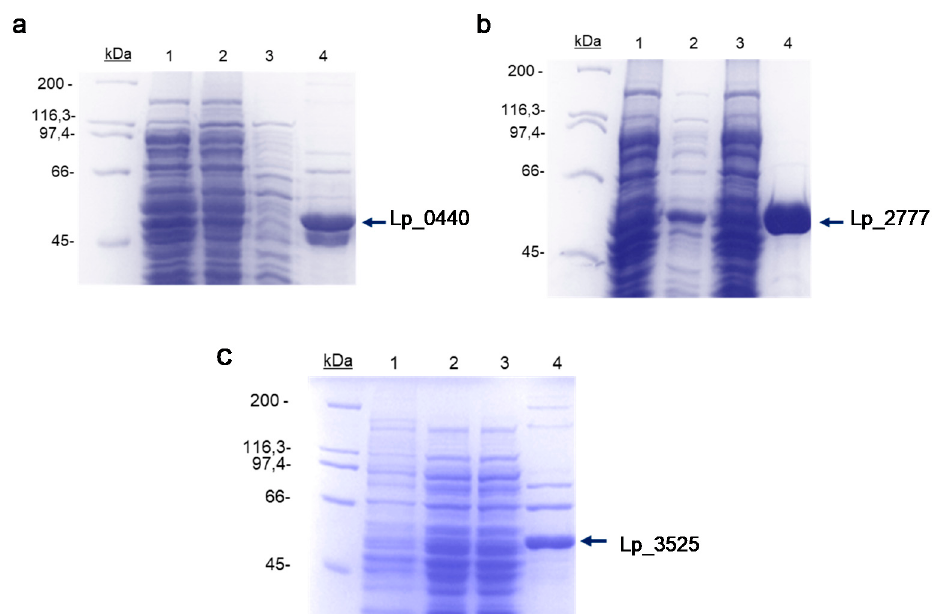
Figure 1. The sodium dodecyl sulfate-polyacrylamide gel electrophoresis (SDS-PAGE) analysis of the purification of different glycosidases from Lactobacillus plantarum WCFS1. ( a ) Lp_0440, ( b ) Lp_2777, and ( c ) Lp_3525. Lane 1: Soluble cell extracts of Escherichia coli BL21 (DE3) (pURI3-Cter for a , b ) or (pURI3 for c ). Lane 2: E. coli BL21 (DE3) (pURI3-Cter-0440 for ( a ), pURI3-Cter-2777 for ( b ), pURI3-Cter-3525 for ( c ). Lane 3: Flowthrough. Lane 4: Protein eluted after His affinity resin and dialysis. The gel was stained with Coomassie blue. Molecular mass markers are located on the left (SDS-PAGE Standards, Bio-Rad, Hercules, CA, USA).